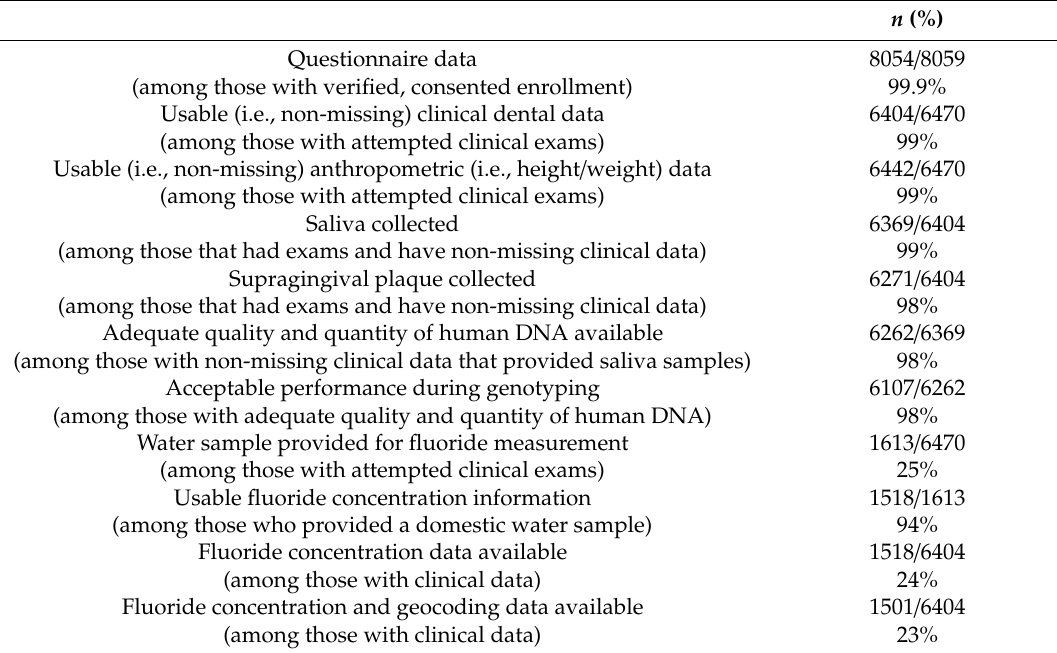
Table 1. Numbers and percentages of participants with non-missing data by domain.